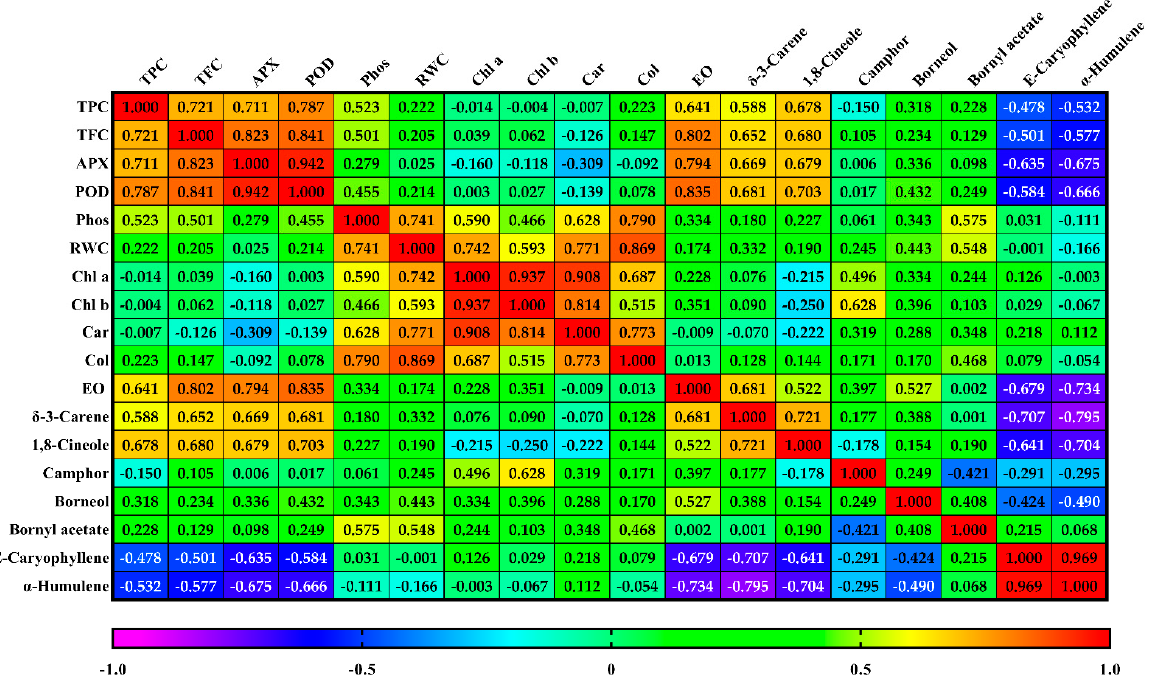
Figure 4. The heat map-based correlation analysis among all biochemical parameters under different irrigation regimes followed by AMF inoculation in S. abrotanoides and S. yangii .